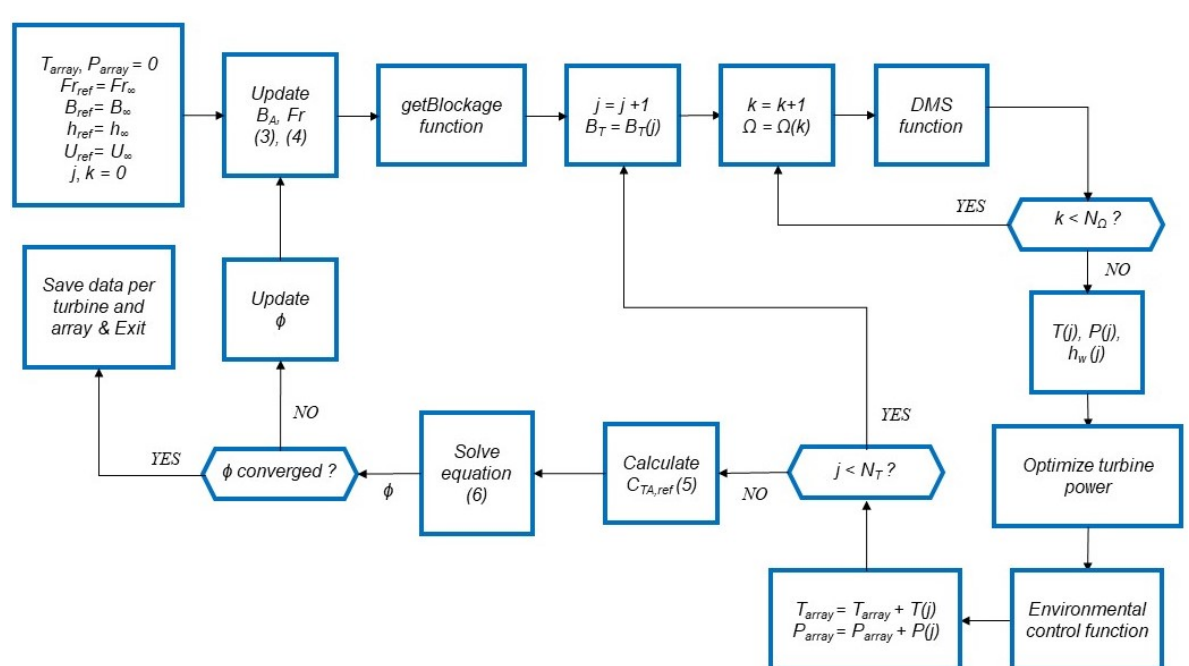
Figure 5. Flowchart of power optimization scheme (M1) for a single array (equal rotor speed for each turbine).